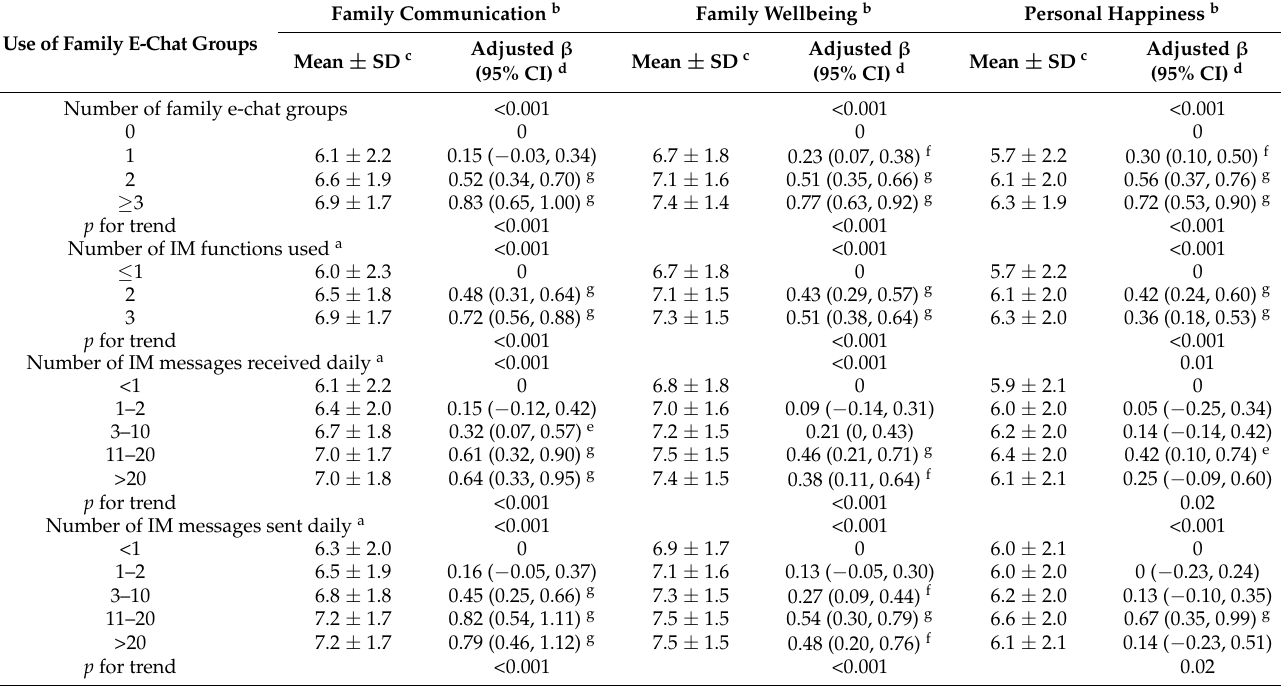
Table 5. Associations of the number of family e-chat groups ( n = 4890) and the use of IM functions ( n = 4046) with family communication, family wellbeing, and personal